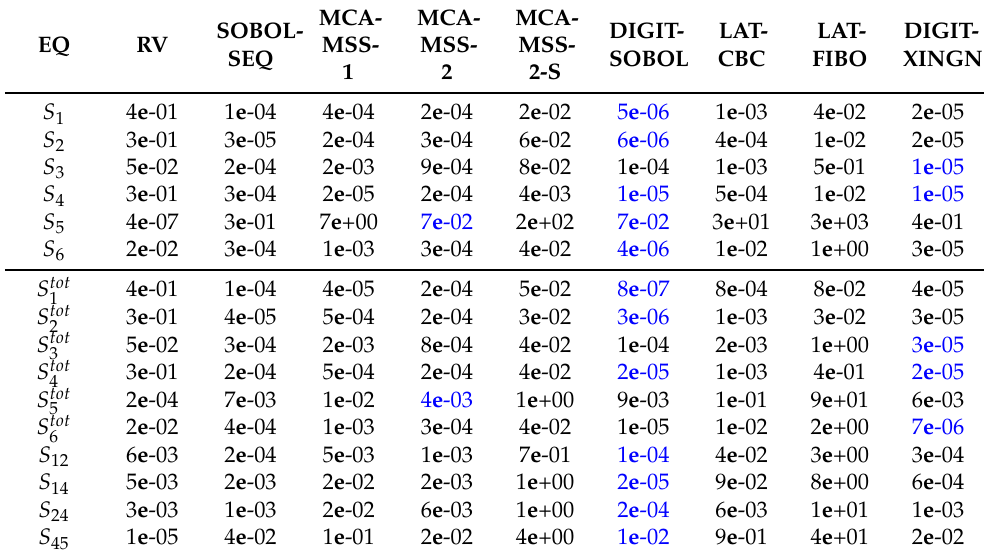
Table 10. RE for AE of SIs ( n = 2 16